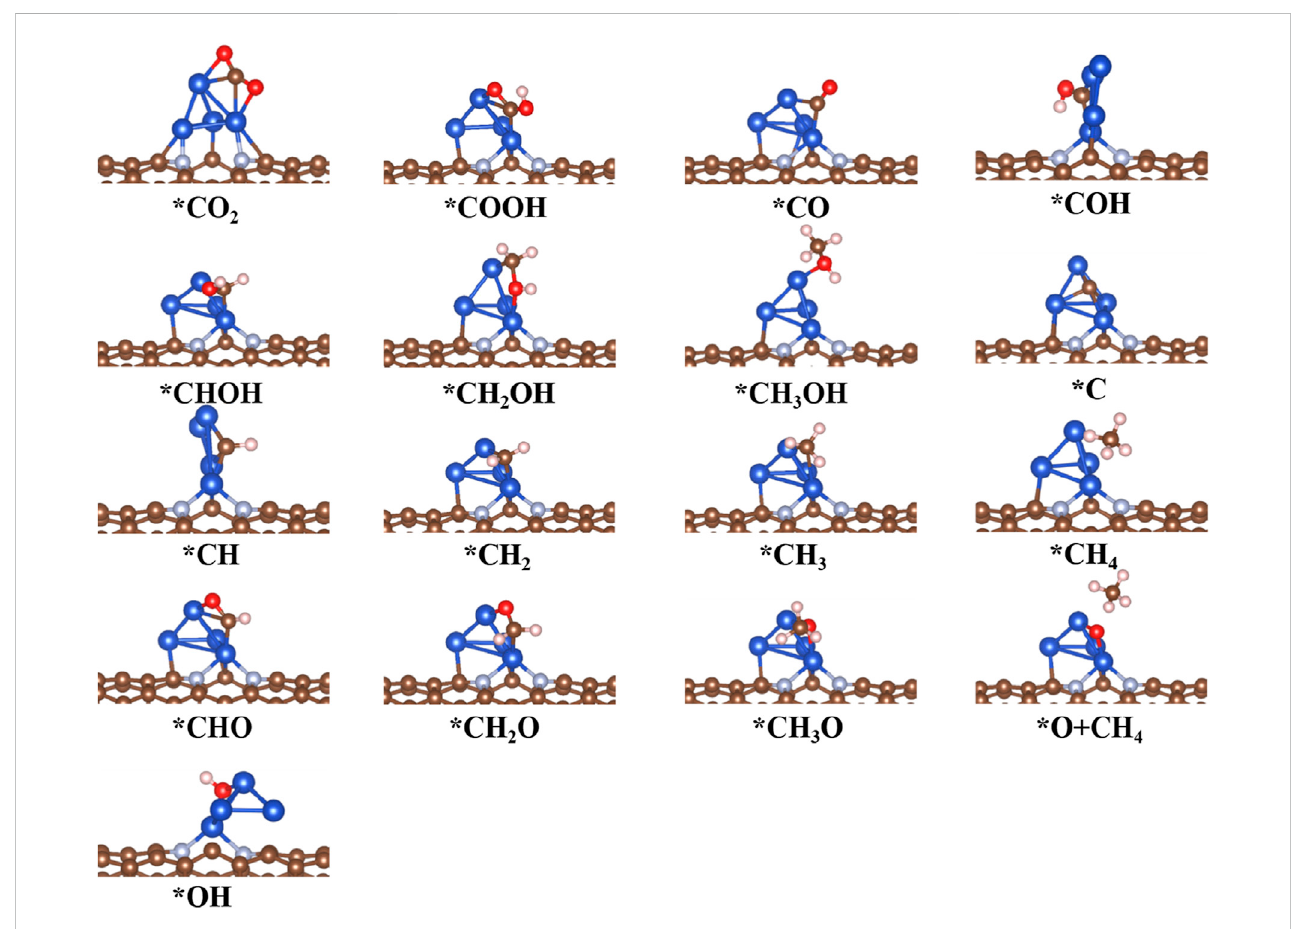
FIGURE 7 Optimized structure of intermediates for CO 2 RR on Cu 4 @CNT surfaces.